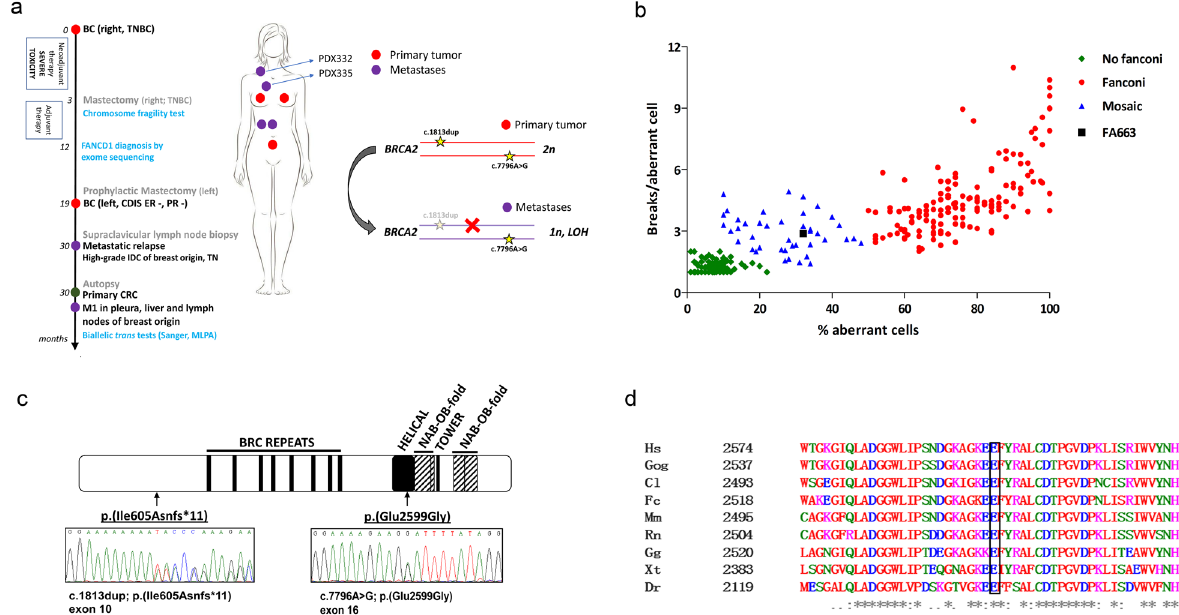
Fig. 1 Breast cancer FA663 patient diagnosed with biallelic BRCA2 -FA disorder. a Timeline of patient ’ s cancer history (diagnoses, treatments, studies) and BRCA2 analysis. b Diepoxybutane (DEB) induced chromosome fragility test (CFT) with blood T-lymphocytes. Percentage distribution of aberrant cells and mean the number of DNA breaks per cell, after DEB induction (0.1 µg/ml). A black square-shaped symbol shows the relative position of FA663 in the distribution of historical data from our laboratory. In the “ no Fanconi ” group only individuals with at least one aberrant cell have been included. c The two BRCA2 pathogenic variants of FA663. BRCA2 protein (P51587) and InterPro domains schematic drawing. Sequenced loss of function variants found in heterozygosis depicted. d the highly conserved amino acid at position 2,599 of the BRCA2 protein. Partial alignment of human BRCA2 with homologous BRCA2 helical domains (IPR015252). BC breast cancer, TNBC triple-negative breast cancer, DCIS ductal carcinoma in situ, IDC invasive ductal carcinoma, ER − estrogen receptors negative, PR − progesterone receptors negative, TN triple-negative, CRC colorectal cancer, M1 metastasis stage 1, MLPA multiplex ligation-dependent probe